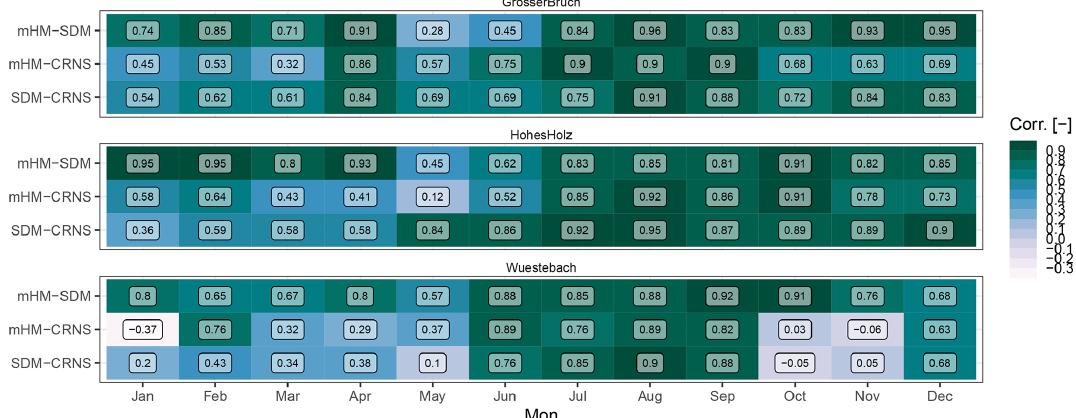
Figure A3. Monthly Spearman rank correlation coefficients for 2014–2019 between deseasonalized SM anomalies simulated by mHM and SM observations from CRNS and SDM measurements and between the CRNS and SDM observations for the three locations Am Grossen Bruch, Hohes Holz, and Wüstebach.